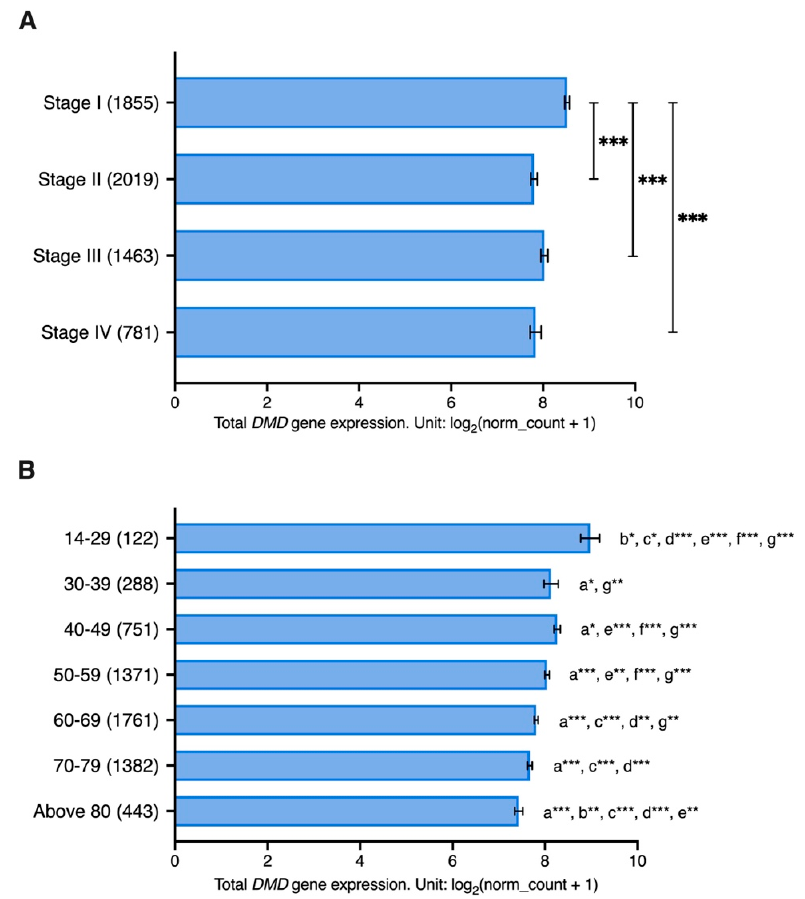
Figure 5. DMD gene expression in tumor samples from 18 TCGA tumors with different ( A ) cancer stages and ( B ) age groups. Expression data is represented as EM mean ± SEM. The number of sam- ples in each group is indicated in brackets. The p -Values were adjusted using the Bonferroni correc-